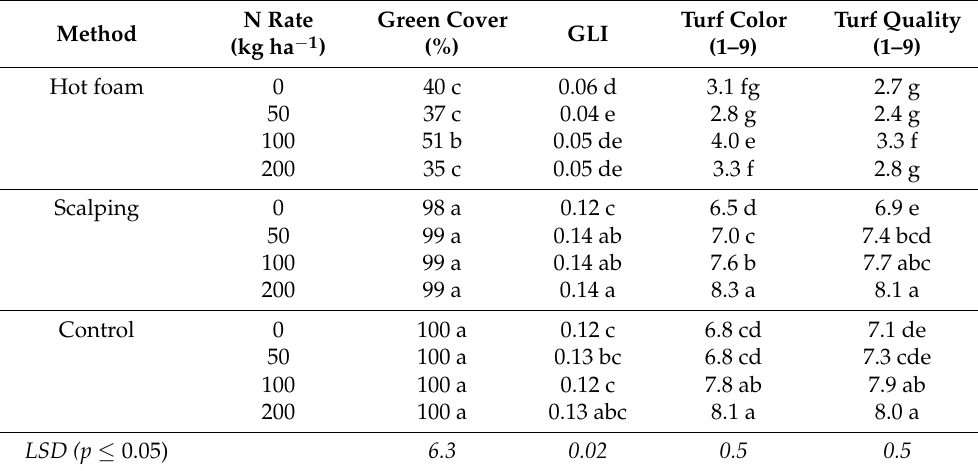
Table 7. Effect of the suppression method x N application pooled over